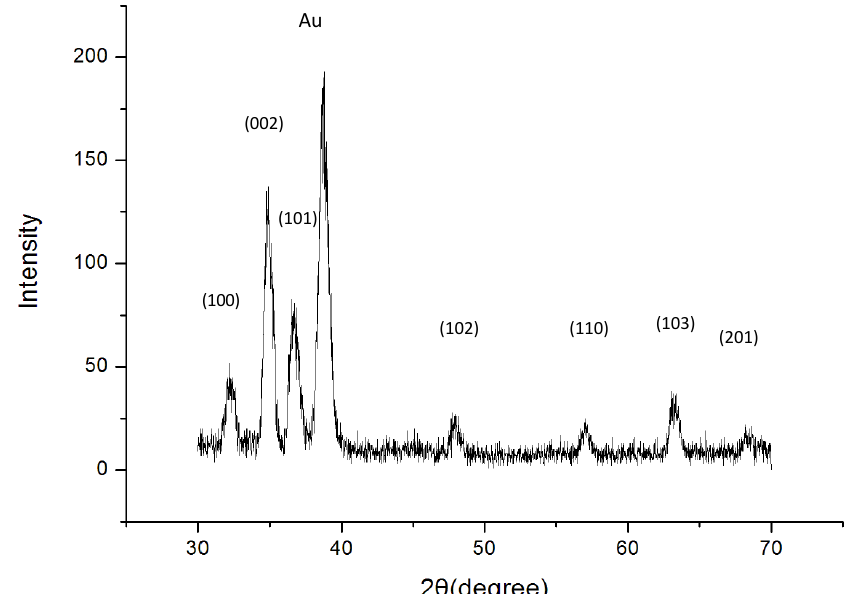
Figure 2. XRD spectrum of ZnO nanorods grown on a gold-coated glass